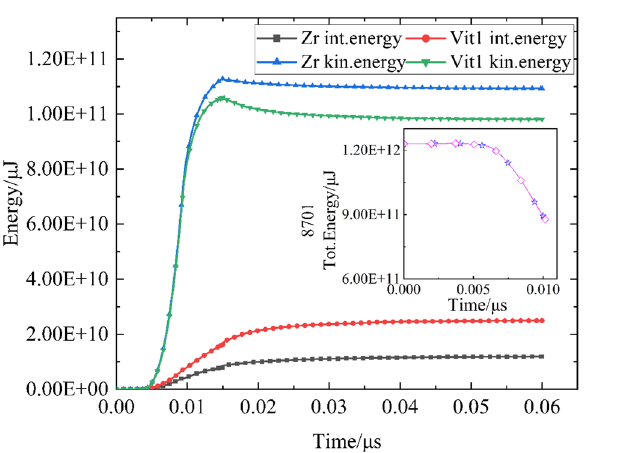
Figure 12. Energy curve of shaped